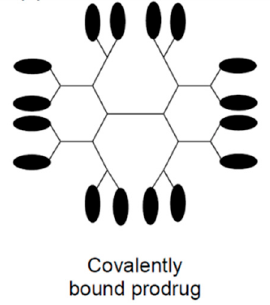
Figure 40. Soluble covalent dendrimer-drug conjugates suitable for targeting and other modifications to optimize circulation residency time and biocompatibility. Reprinted with permission from [111]. Copyright 2002 Elsevier.